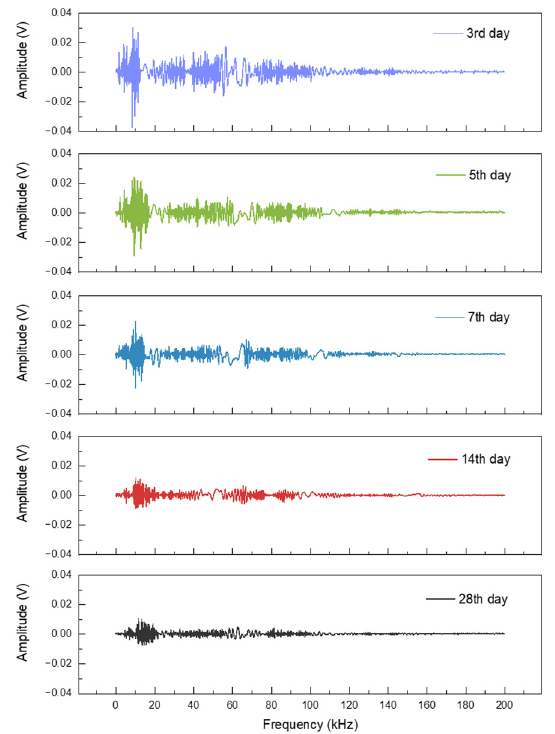
Figure 5. The received signal of P.O 42.5 specimens with swept sine excitation on the 3rd, 5th, 7th, 14th, and 28th days.